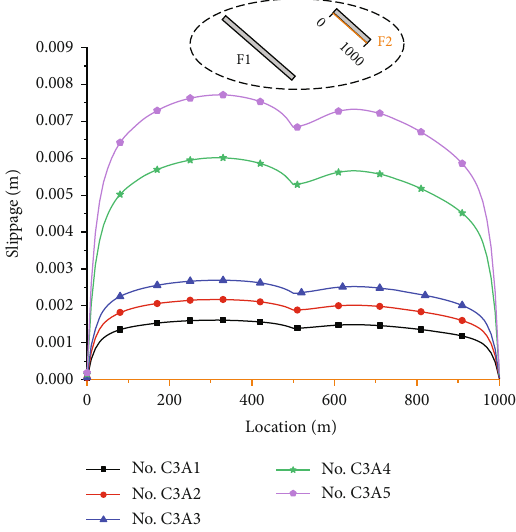
Figure 26: The induced fault slippage of F1 of di ff erent fracturing region areas (Nos.